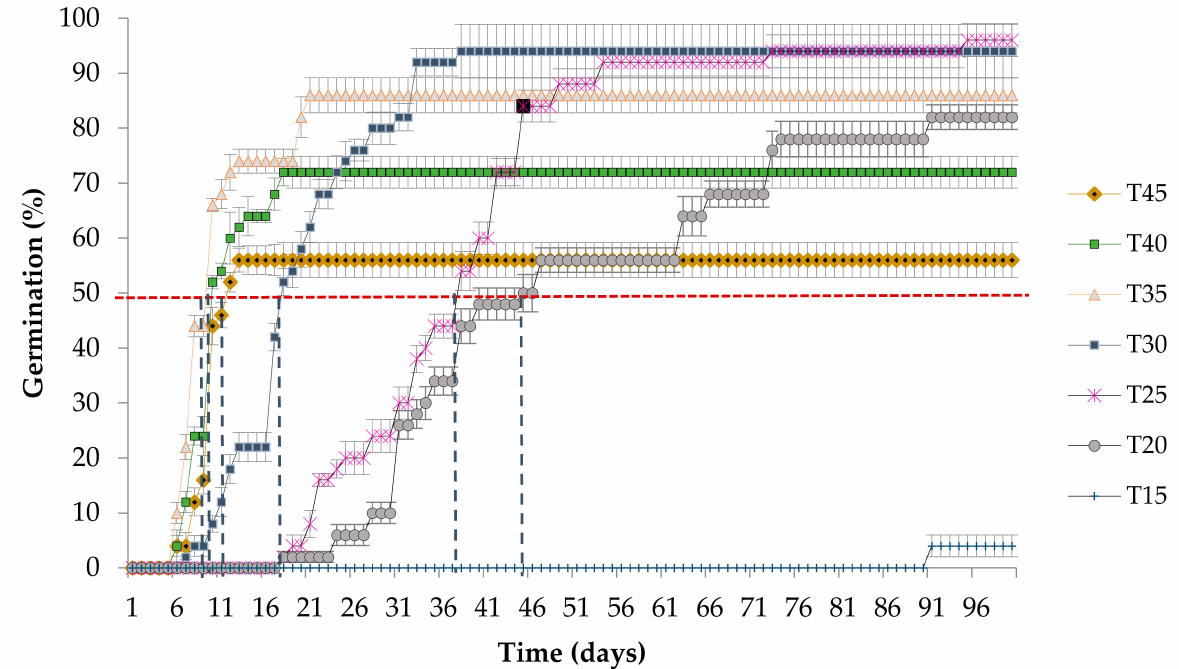
Figure 2. Cumulative seed germination percentages and time required for 50% germination at each temperature treatment (dashed vertical lines in blue). The error bars show standard